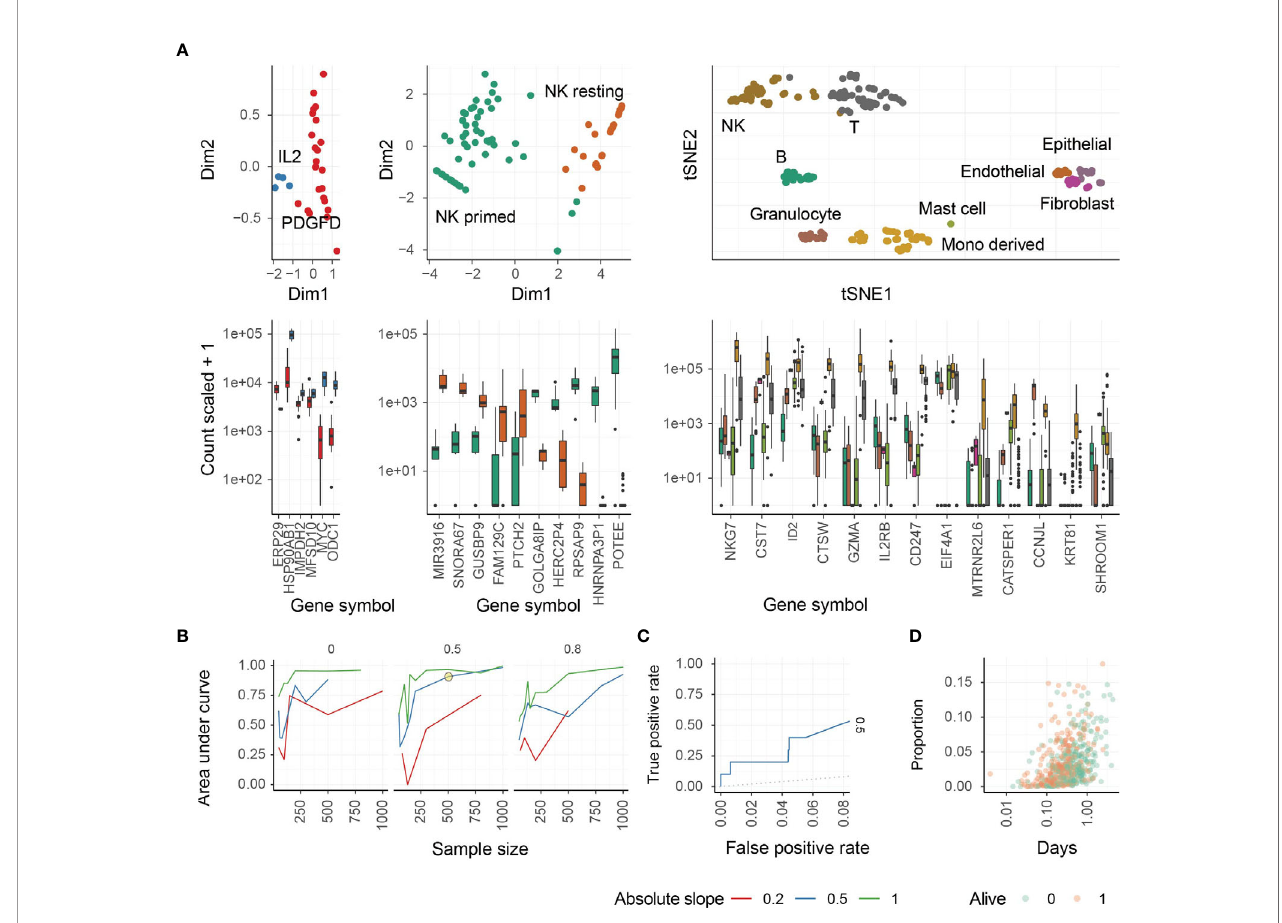
FIGURE 1 | Identi fi cation of different NK cell phenotypes using transcriptional signatures. (A) Study of transcriptomic signatures for activated NK cells (left), all NK cell phenotypes (middle), and all cell types (right). On the top the principal components or the t-distributed stochastic neighbor embedding dimensions for the biological replicate within the reference dataset are shown. On the bottom, the relative transcriptional abundance is shown for marker genes. (B) Test for accuracy of the inference of PDGF-DD activated NK cell proportion from simulated mixtures. This plot represents the accuracy of the combination of CIBERSORT with Cox- regression by inferring associations between convoluted tissue composition and survival time. The three facets represent low-to-high proportion of missing information (proportion of total cells being of neural origin in the simulated mixtures, for which signature was not present in the reference). Data was simulated across a range of sample-size and slopes. A simulation condition that represents the associations we detected in the TCGA database is circled. (C) Receiver Operating Characteristic (ROC) curve, measuring the accuracy (true-positive and false-positive) for the simulated mixture circled in panel (C, D) The underlying association between the positively associated cell types with survival days, of the simulated dataset circled in panel (C)